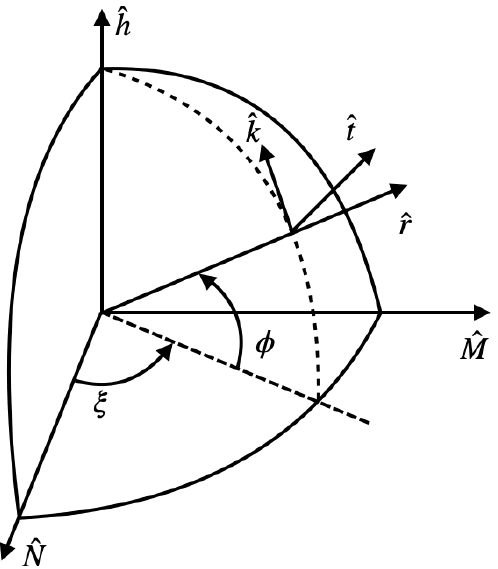
Figure 1. Representation of the inertial and moving